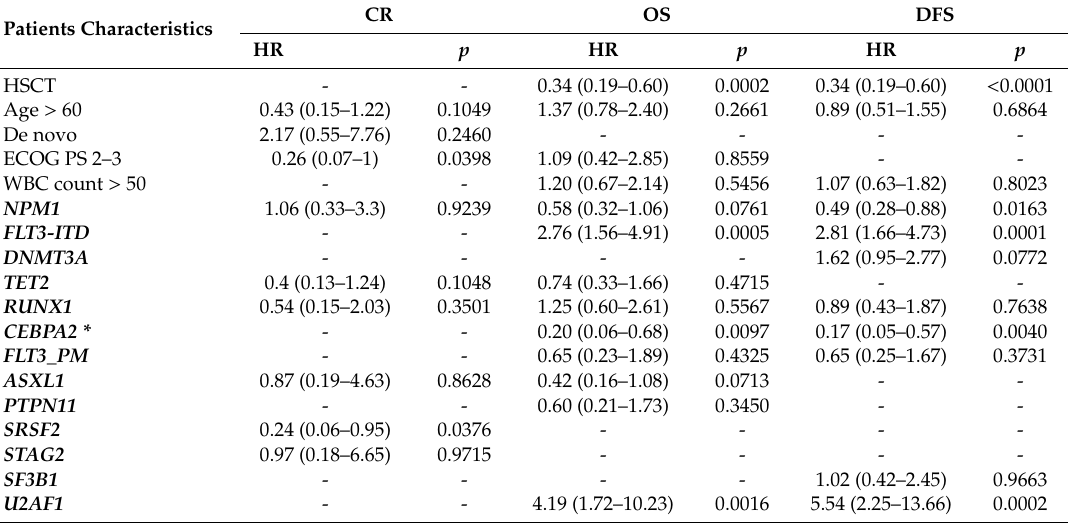
Multivariable analysis for patients characteristics, treatments and mutations in the